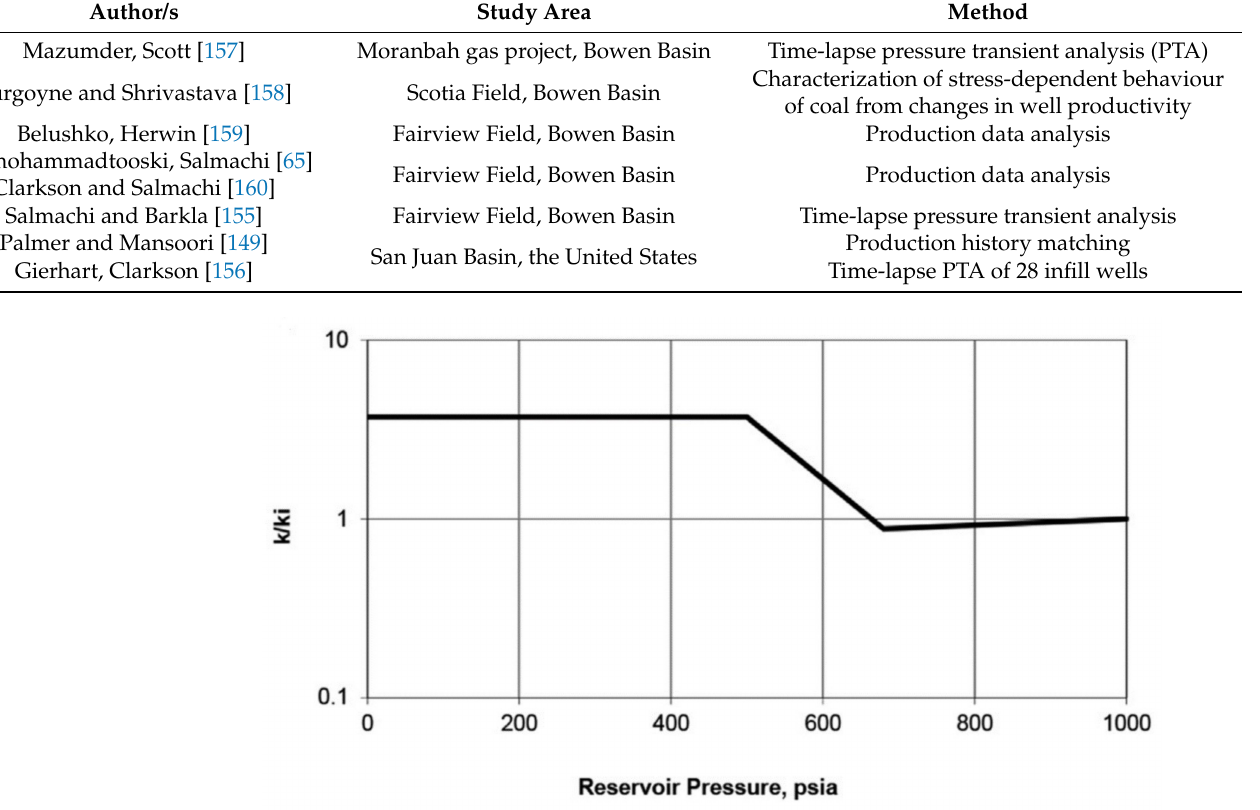
Figure 10. Change in permeability as a function of average reservoir pressure above and below the desorption pressure [160]. There is a slight decrease in permeability above desorption pressure due to stress-dependency of permeability followed by a sharp increase in a short period due to matrix shrinkage effect and then permeability remains unchanged (This figure was originally published in Journal of Natural Gas Science and Engineering Volume 40 Pages